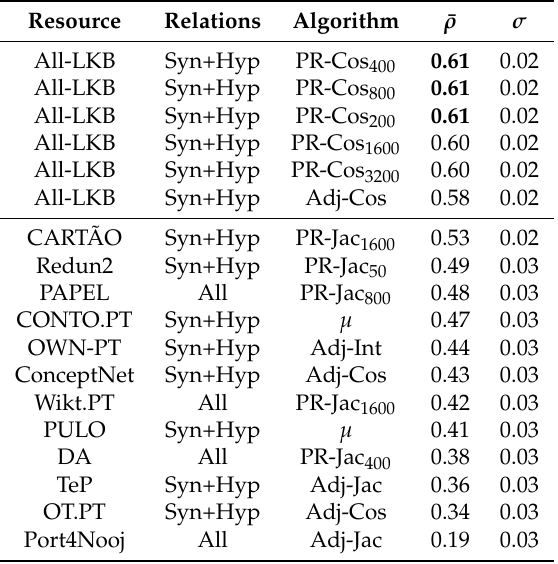
Table 8. Performance overview of LKBs in the SimLex-999